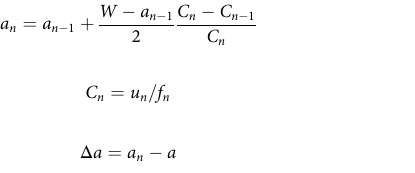
where a n and C n are the crack length and complaisance calculated at each point after the departure of the creak, respectively. u n and f n are the displacement and force at each point after departure of the crack, respectively. W is the width of the specimen. Finite element analysis of the BM structure . A 3D nonlinear fi nite element model is developed using the commercial software ABAQUS v6.13. In the simulation, a 3D BM structure (250× 60 ×2 µ m 3 ) with a single-edge notch (2 µ m ×4 µ m×2 µ m) is adopted, as shown in Supplementary Fig. 12a. The BM structure in the FE model contains a randomly staggered arrangement of bricks bonded by the thin layer of biopolymer, which is modeled as a cohesive zone with a bilinear traction separation and undergoes dry friction after damage. The bricks with isotropic bulk modulus E p = 100 GPa, Poison ratio v p = 0.33, and the failure strength σ m p = 200 MPa bear elastic deformation before brittle failure. The bilinear constitutive response of traction separation law is shown in Supplementary Fig. 12b. The initial response of the cohesive element is assumed to be linear until a damage initiation criterion is met. The energy-based Benzeggagh and Kenane (BK) damage evolution criterion with a mixed mode fracture is adopted. In the standard BK option in Abaqus, when the accumulated energy release rates G ( G = G I + G II ) is larger than the critical energy release rate G c , the interface is fully fractured. Here G c is de fi ned as G Ic þ G IIc (cid:2) G Ic ð